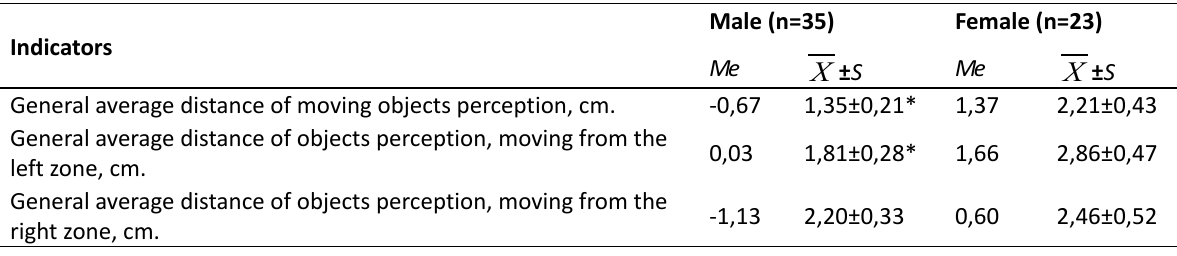
Table 2. Indicators of the reaction to a moving object of basketball players aged 12-13 aged during monocular perception (the left eye).